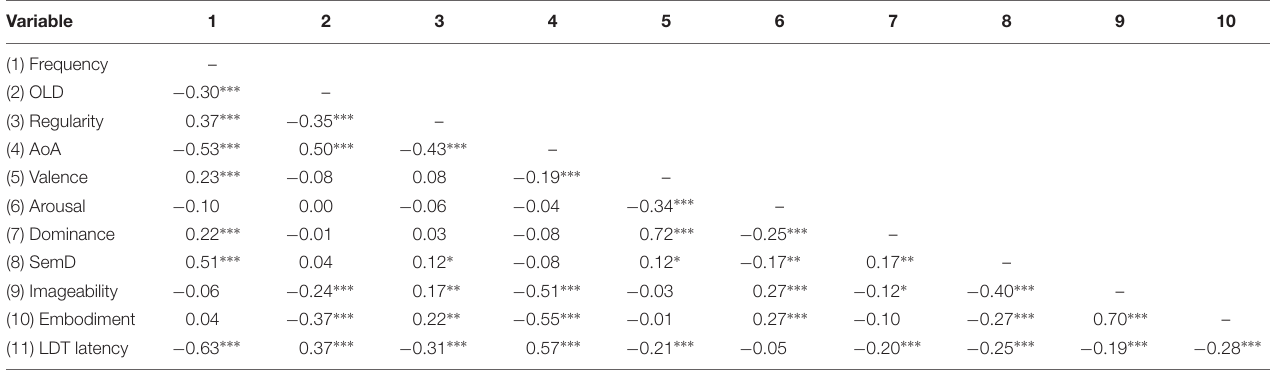
TABLE 2 | Correlations between predictor variables and dependent measures in Experiment 1 (LDT). Variable